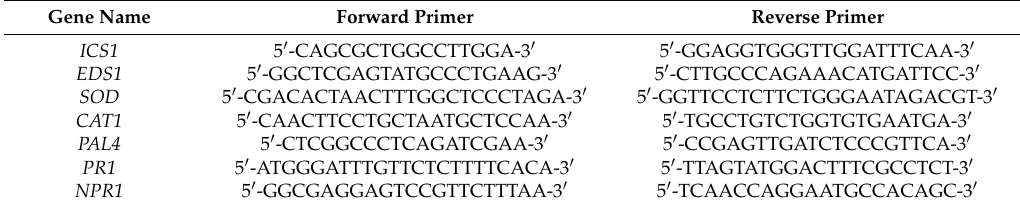
Table 3. The primer sequences and reaction condition used in